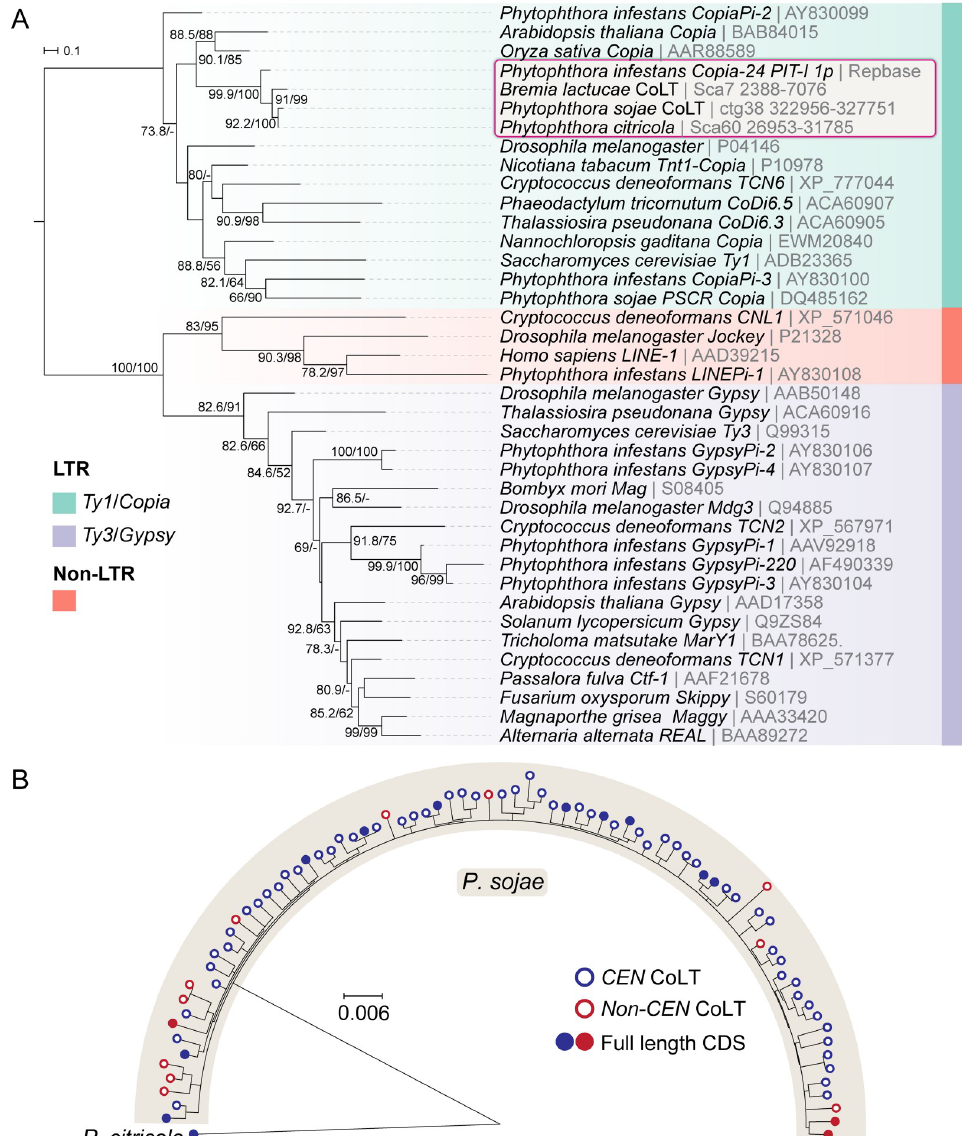
Fig 6. Phylogenetic analyses of CoLT. (A) Maximum-likelihood phylogeny of different retroelements. Protein sequences of the reverse transcriptase (RT) domains were used to construct the tree [87] (see S4A File for the complete DNA and protein sequences). The tree was rooted in the midpoint and branch support values ( > 50%) shown at the three nodes were determined by 10,000 replicates of both ultrafast bootstrap approximation (UFBoot) and the Shimodaira- Hasegawa approximate likelihood ratio test (SH-aLRT). (B) Maximum-likelihood phylogeny of full-length CoLT elements identified in the Psojae2010.1 genome assembly. CoLT copies located inside and outside of centromeres are denoted by blue and red circles. CoLT elements with full-length coding sequences (CDS) are depicted as filled circles. A CoLT sequence identified in P . citricola served as an outgroup. See S4B File for the CoLT copies used for the phylogenetic